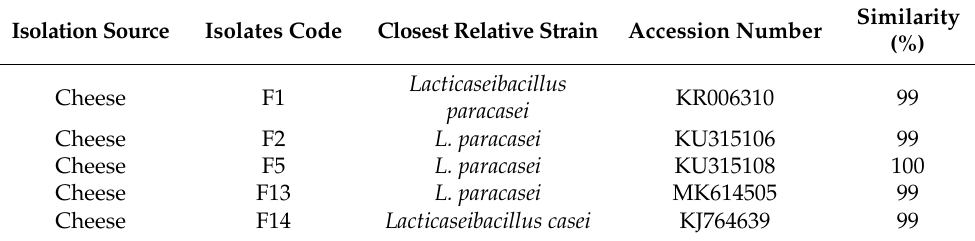
Table 2. Identification of the 16S gene sequences from selected bacterial